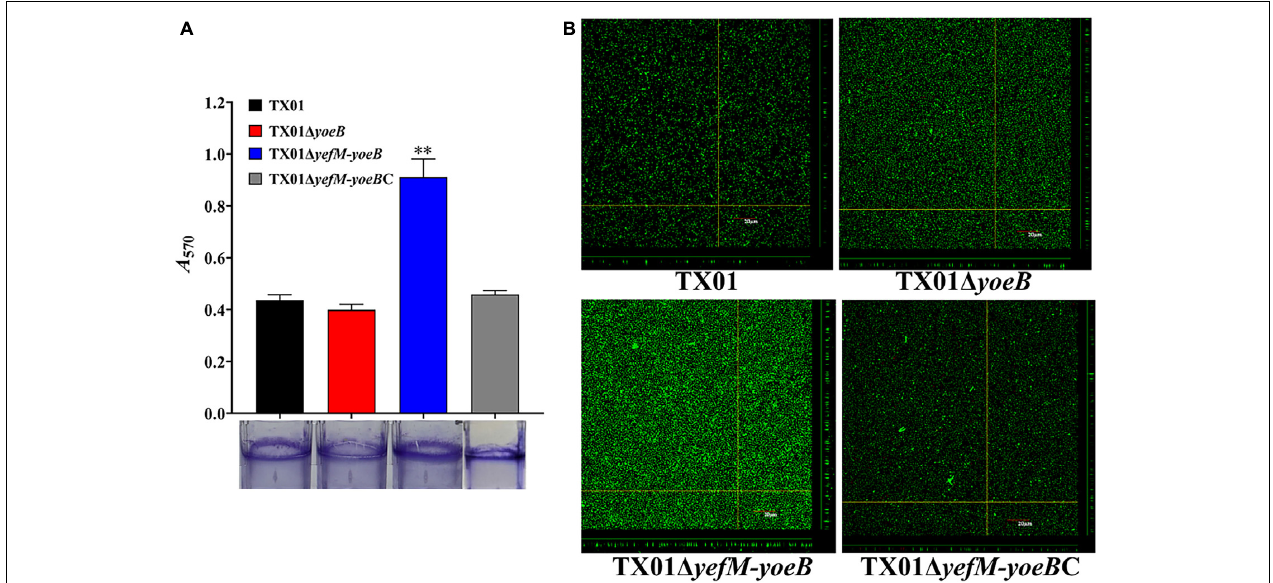
FIGURE 4 | Effects of yeoB and yefMyeoB mutation on bacteria biofilm growth. (A) Biofilm-forming capacity of E. piscicida . TX01, TX01 (cid:49) yeoB , TX01 (cid:49) yefMyeoB , and TX01 (cid:49) yefMyeoB C were incubated in polystyrene plates, and biofilm formation was determined by measuring the A 570 of the final eluates of crystal violet staining. Data are presented as the means ± SEMs ( N = 3). N, the number of times the experiment was performed. ∗∗ P < 0.01. (B) The viability of biofilm growth of E. piscicida as determined by confocal laser scanning microscopy (CLSM). Cells in the biofilms were stained with a BacLight LIVE/DEAD kit to reveal viable (green fluorescence) and non-viable (red fluorescence)